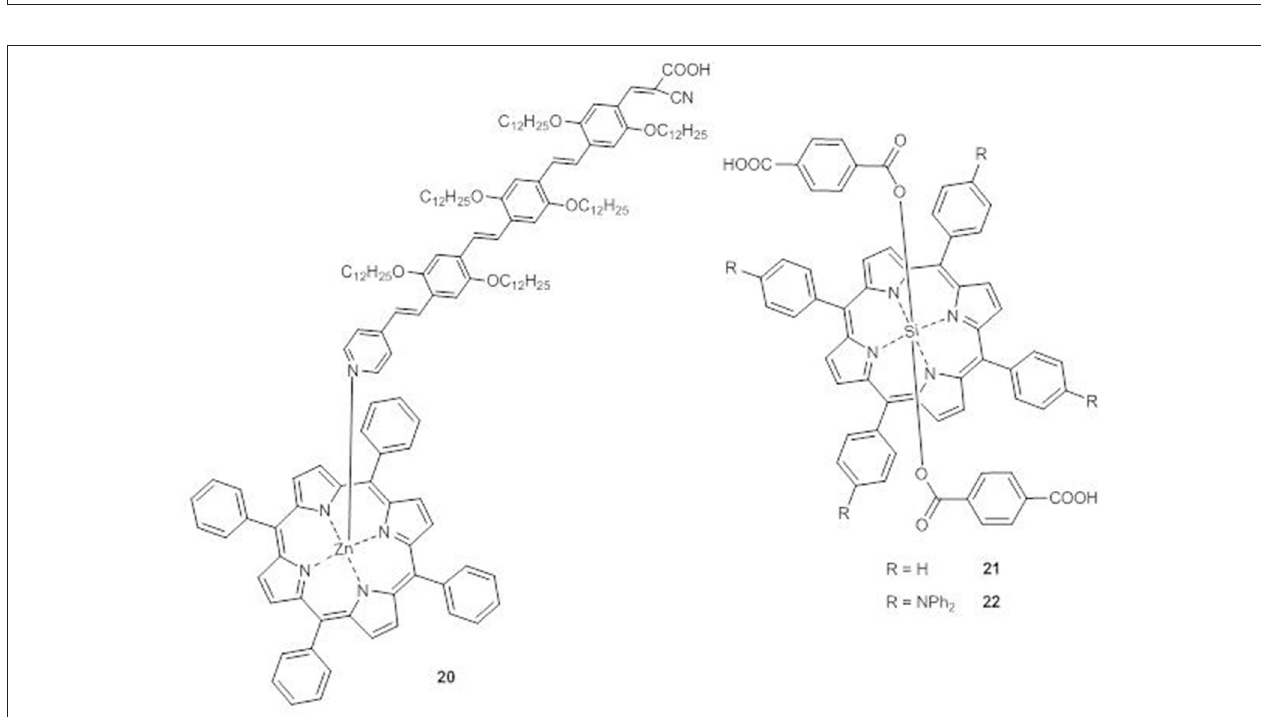
FIGURE 10 | Axial porphyrins 20-22